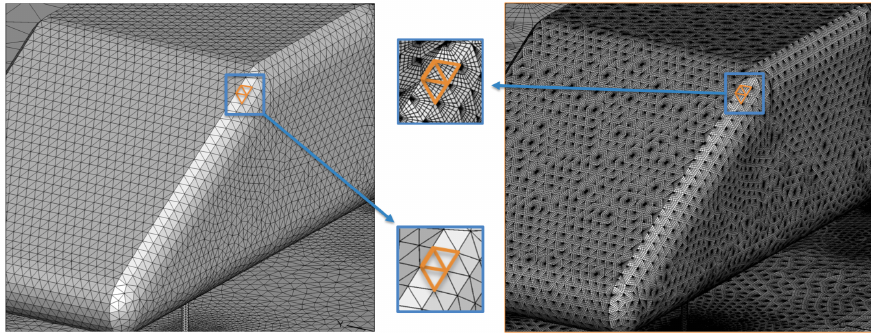
Figure 3. Meshing approach. ( Left ) Linear base mesh ( Right ) High-order